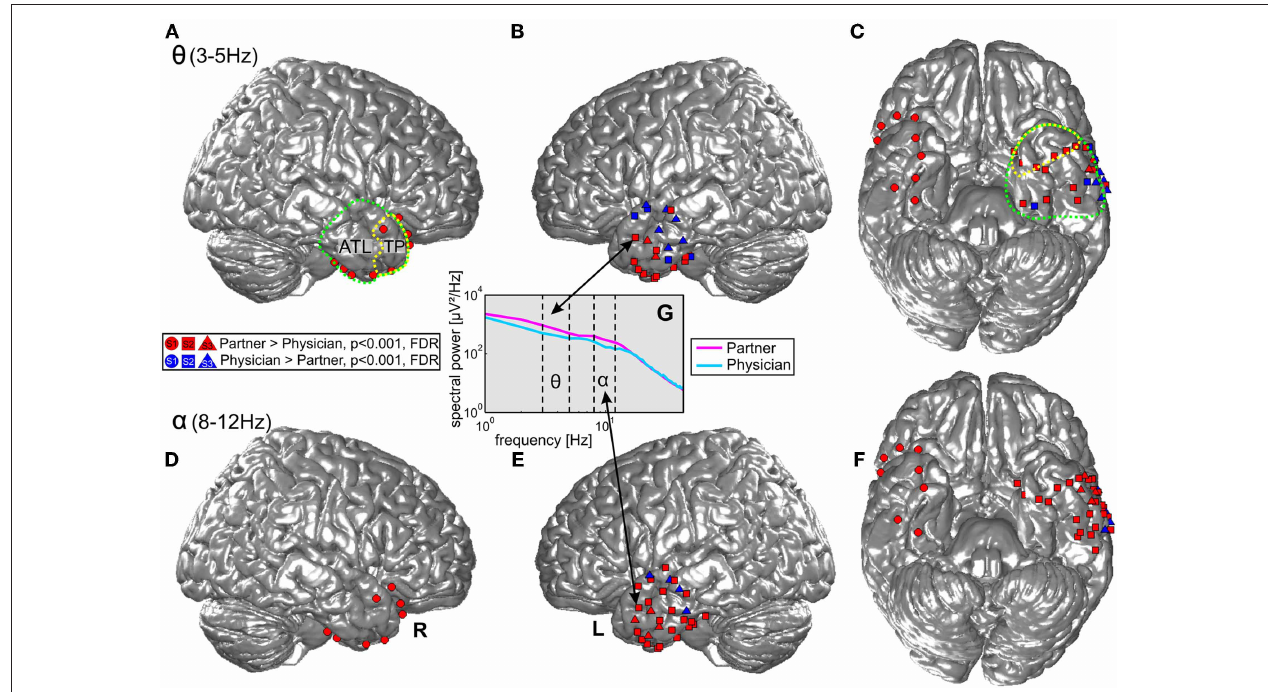
FIGURE 4 | Projection of ECoG electrode positions on an SPM standard brain. Dots, squares, and triangles depict ECoG electrodes from S1, S2, and S3, respectively. Red: enhanced activity in the theta (top row) and alpha (bottom row) bands during conversations of the three patients with their life partners (C1) in comparison with conversations with their physicians (C2). Blue: electrodes with significantly enhanced activity in C2 > C1. Green and